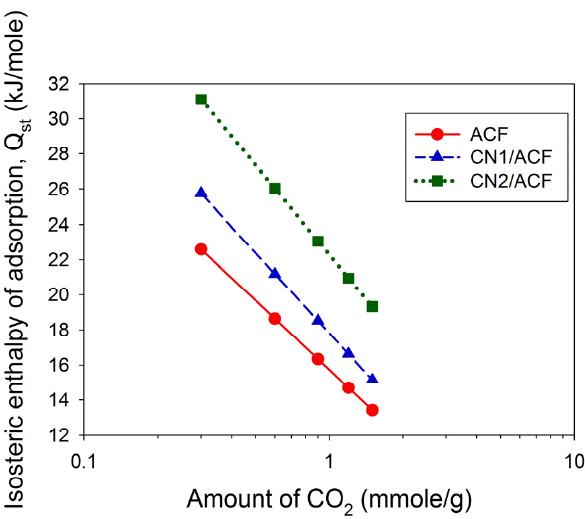
Figure 7. The isosteric enthalpy of the adsorption of CO 2 on all samples: ( a ) as-received activated carbon fibers (ACF); ( b ) ACF grafted with N-doped carbon nanotubes (CN1/ACF); ( c ) ACF pre-immersed with cobalt(II) acetate and grafted with N-doped carbon nanotubes (CN2/ACF).